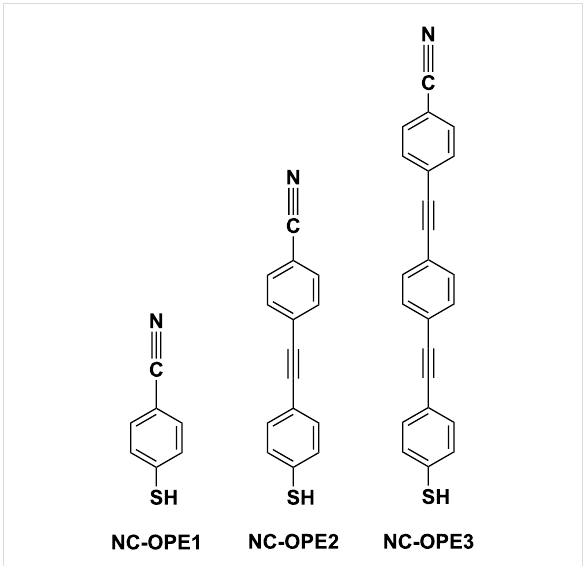
Figure 1: A schematic drawing of the target molecules along with their